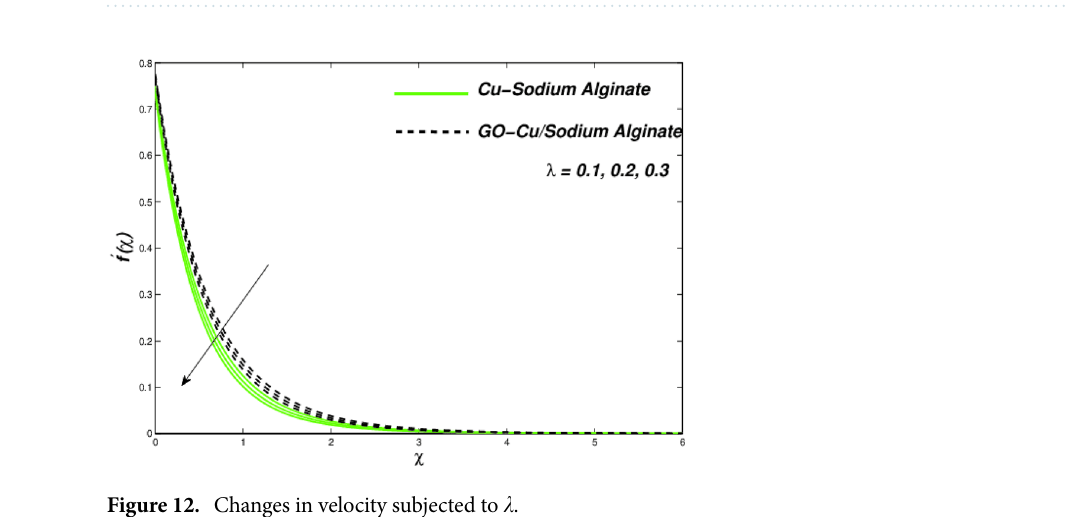
Figure 11. Entropy variations with variable B i .